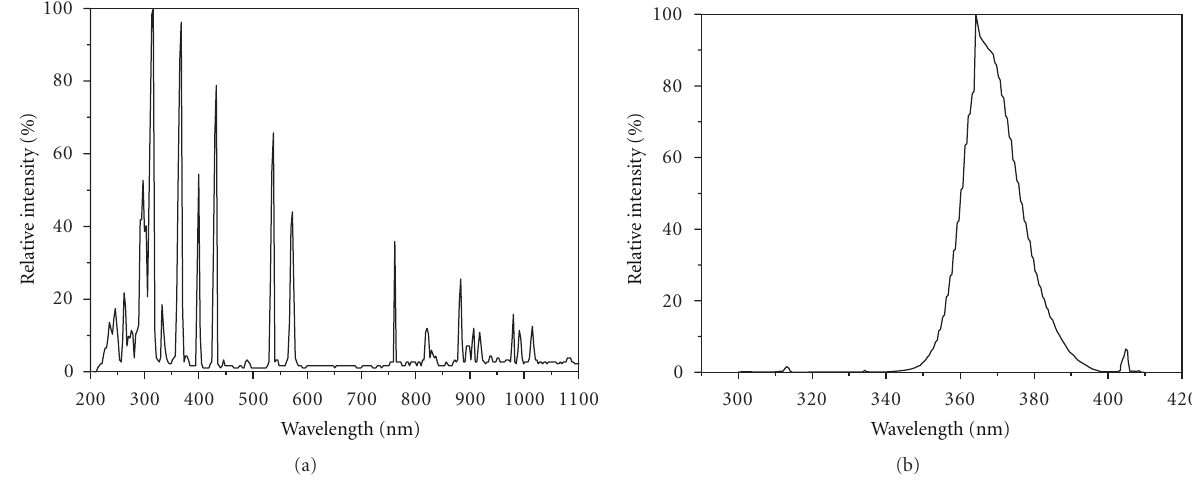
Figure 1: UV spectra of 250 W UV high pressure mercury lamp (a) and 8W black light lamp (b).